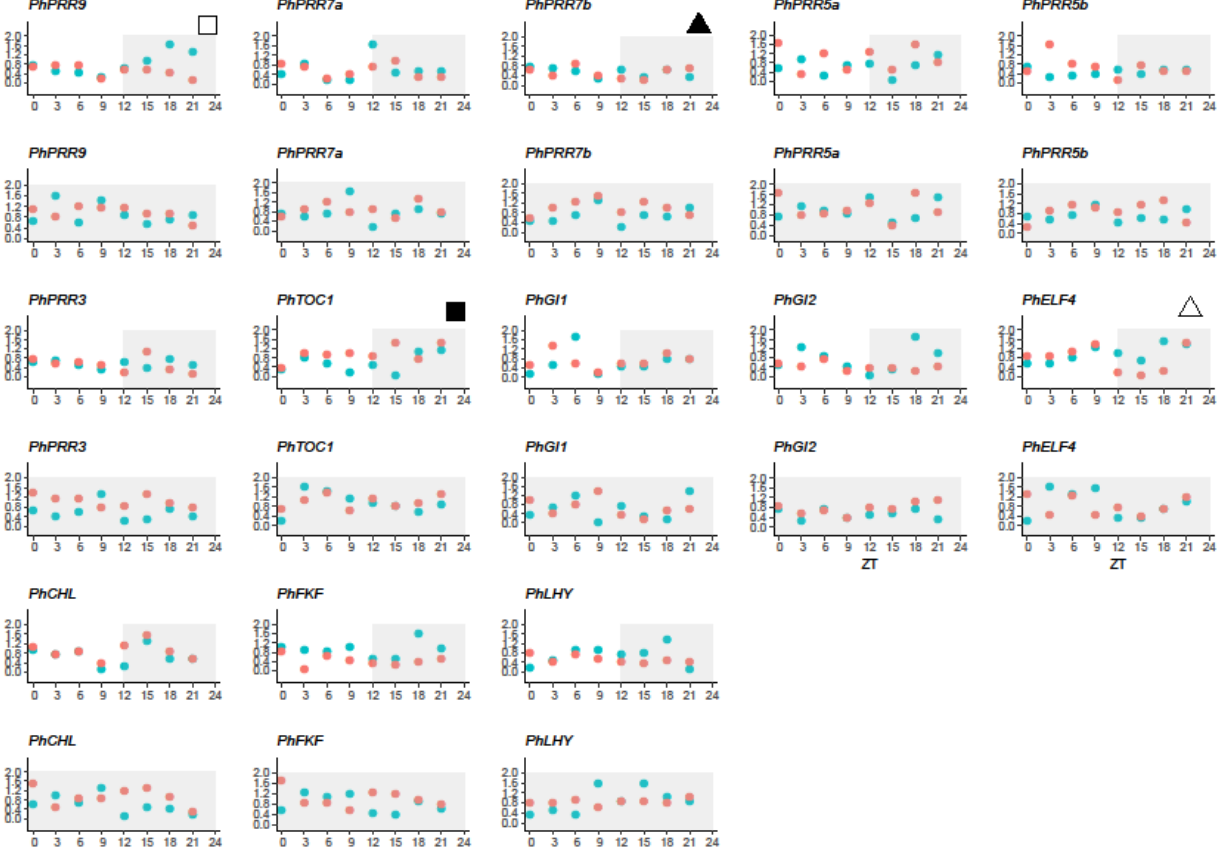
Figure 5. Variability in clock gene expression in petunia leaves (red) and petals (blue) under a light:dark cycle. Coefficient of variation (CV) was calculated for every clock gene and time point for leaves (red) and petals (blue). ZT 0 (zeitgeber time) indicates light on, ZT12 indicates light off. White area represents the light period and grey area, the dark period. The black triangle denotes a gene with low variation in both tissues and the white triangle, a gene with high variation. The white square indicates a gene with high CV in petals whereas the black square denotes a gene with high variation in leaves.